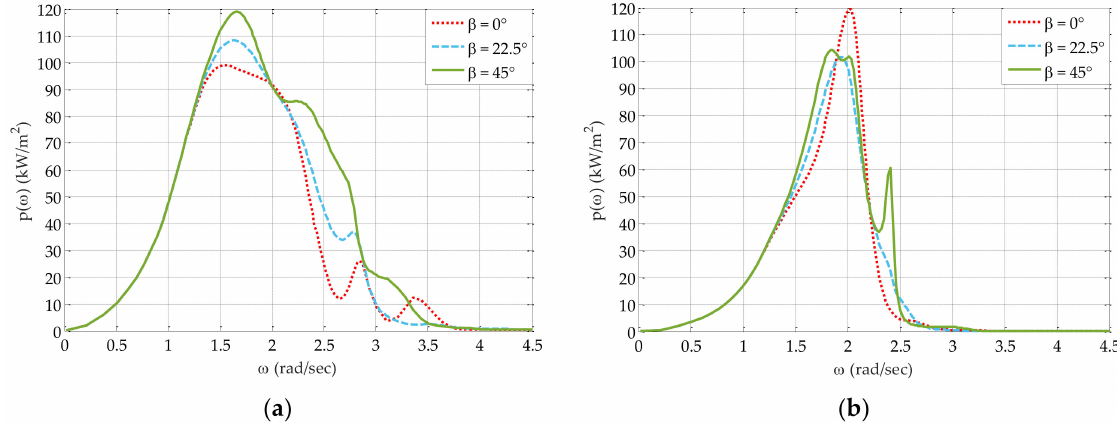
Figure 14. Effect of β on the mean power absorbed by the array with ( a ) oblate spheroidal WECs and d net = 0.125 r 0 ; ( b ) hemispherical-shaped WECs and d net = 0.25 r 0